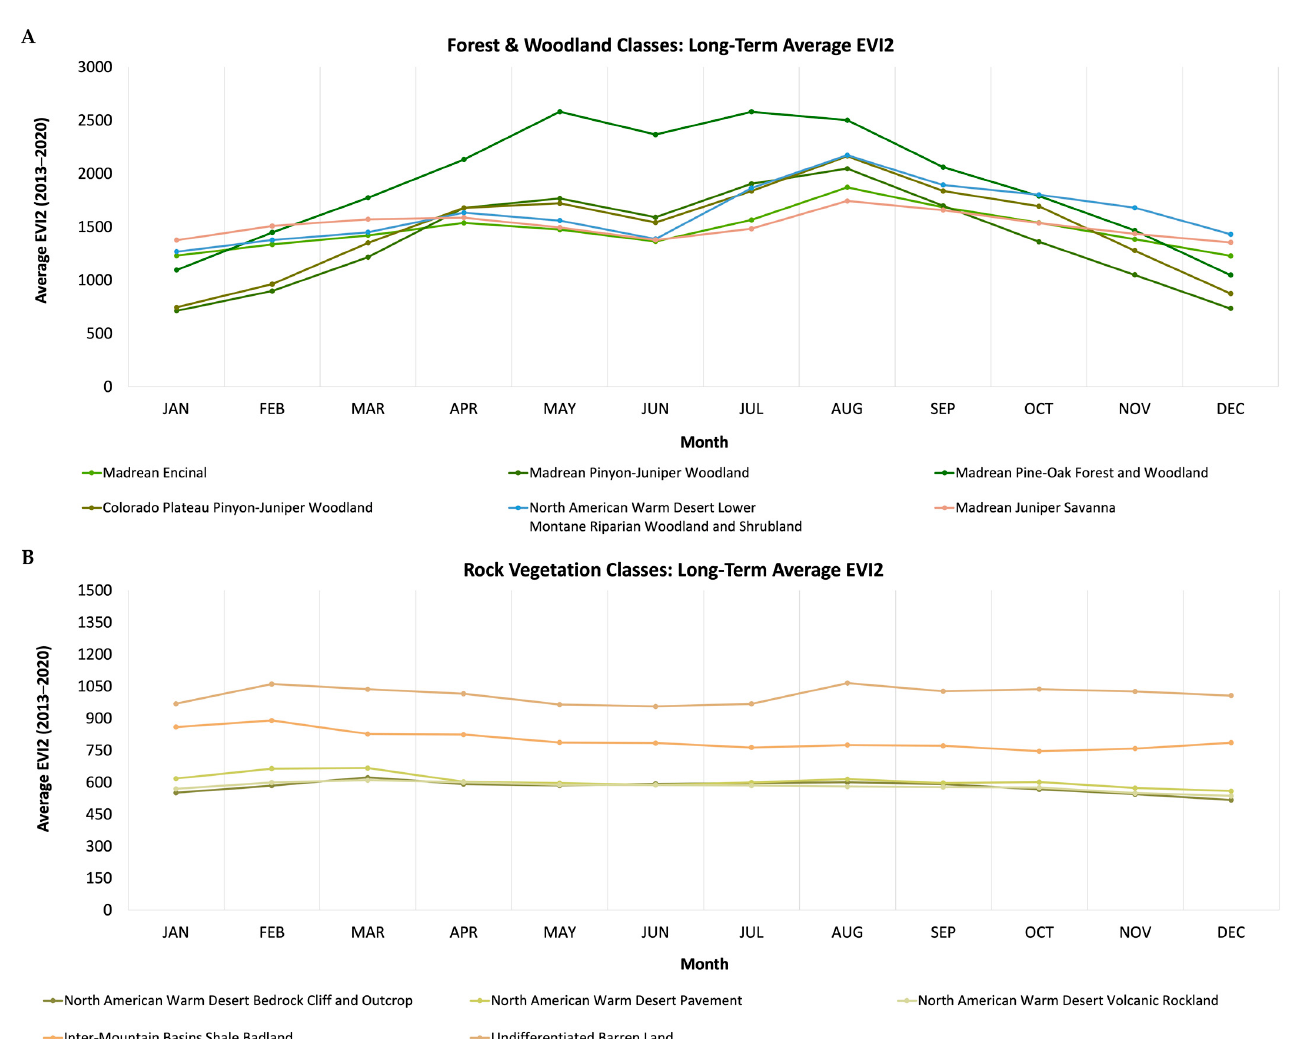
Figure 10. Long-term annual average EVI2 time series from 2013 to 2020 for ( A ) forest and woodland classes and ( B ) rock vegetation classes.